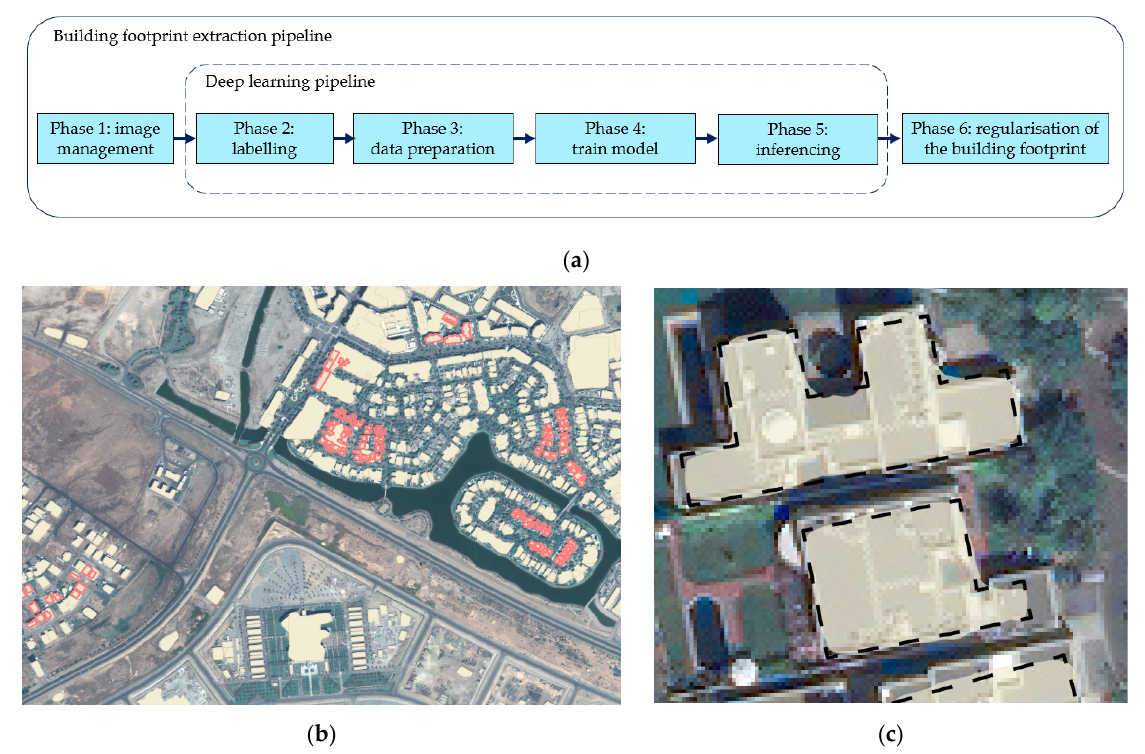
Figure 4. Building footprint extraction: The pipeline ( a ), training build, in red color, and footprint building, in yellow, generated through deep learning ( b ) and the detail of some buildings, in black dashed line, where the application of the shape regularization function is shown ( c ).